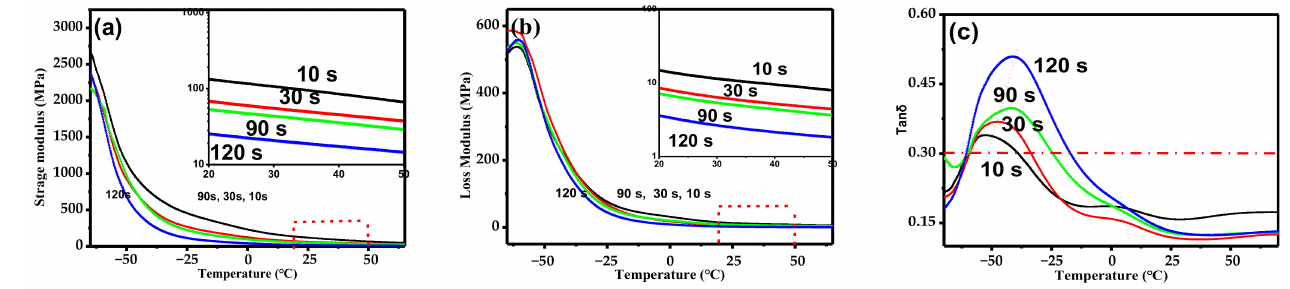
Figure 6. DMA thermogram of IIR/PP-TPV with different DV times: ( a ) E (cid:48) , ( b ) E (cid:48)(cid:48) , and ( c ) Tan δ .